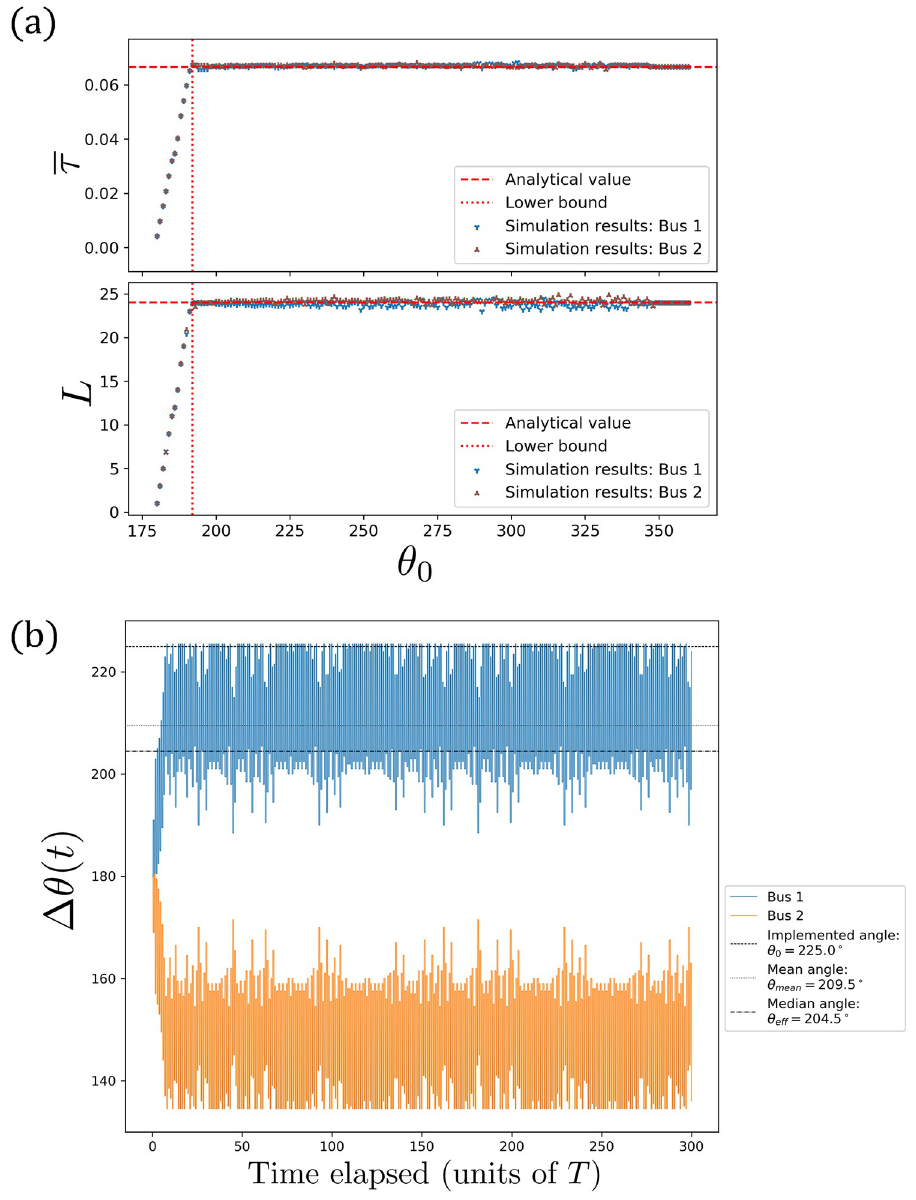
Fig 3. (a) Graphs of � t and L versus θ 0 for each of the two buses. These simulation results agree with Eqs (4) and (5), as well as the lower bound θ min from Eq (7). Shown here [as well as in (b)] is for k = 1/16, and these features similarly hold for any value of (fixed) k . (b) Graphs of Δ θ ( t ) versus time for each of the two buses. The no-boarding policy kicks in if Δ θ >